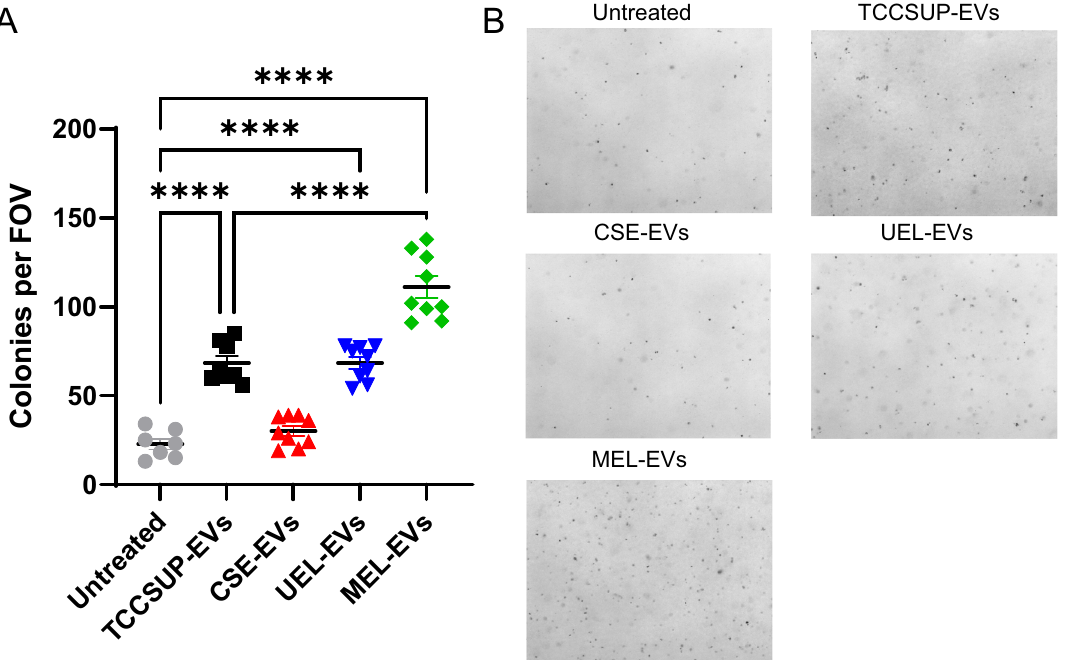
Figure 5. E-liquid-induced BCEVs promote the malignant transformation of SV-HUC cells. SV-HUC cells in 24-well plates were treated twice per week with the indicated BCEVs (20 µg/mL) for 12 weeks. After a 4-week recovery period, a soft agar colony formation assay was performed using these cells (6 wells/treatment condition), with five random fields of view per well being imaged after 6 weeks. The number of colonies in each well was analyzed across five random FOVs in each well ( A ), with representative FOVs being shown in ( B ). Data are means ± SEM. ****P < 0.0001, one-way ANOVA with Tukey’s post hoc